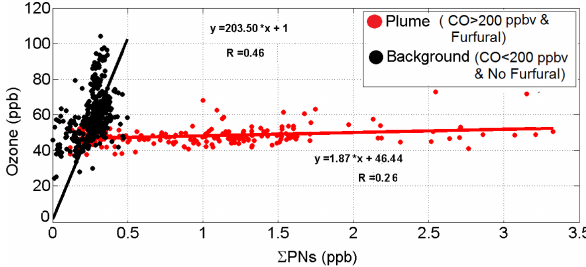
Figure 6. Scatter plot between measured O 3 and measured P PNs for the flights B619, B622, B623, B624, and B630. Straight line is best-fit linear regression. Plume identification follows the method- ology and the analysis described in Sect. 3.2 and reported in the